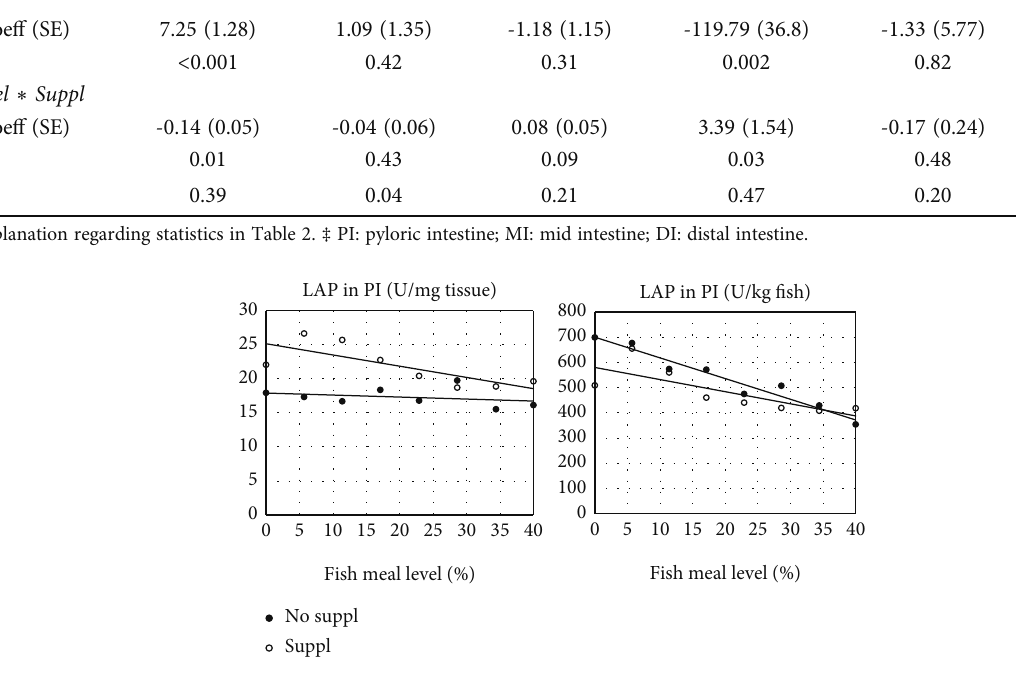
Figure 7: E ff ects of increasing fi shmeal level on the activity of leucine-aminopeptidase (LAP) activity in chyme from the pyloric intestine (PI) in fi sh fed two series of diets, one without (No suppl) and the other with (Suppl) mixture of supplements, i.e., 0.3% choline chloride, 0.05% β -glucan, and 0.05% nucleotides. For statistics, see Table 6. Table 7: Results of analyses of regression regarding the classical plasma biomarkers on dietary fi sh meal level (FM level), e ff ects of supplementation (Suppl) and interaction e ff ects †‡